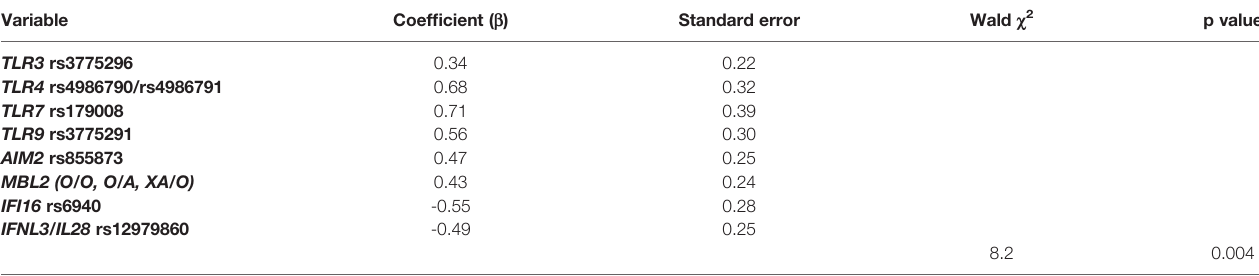
TABLE 3 | Calculation of the CMV genetic risk score: variables selected in the logistic regression model. Variable Coef fi cient ( b )